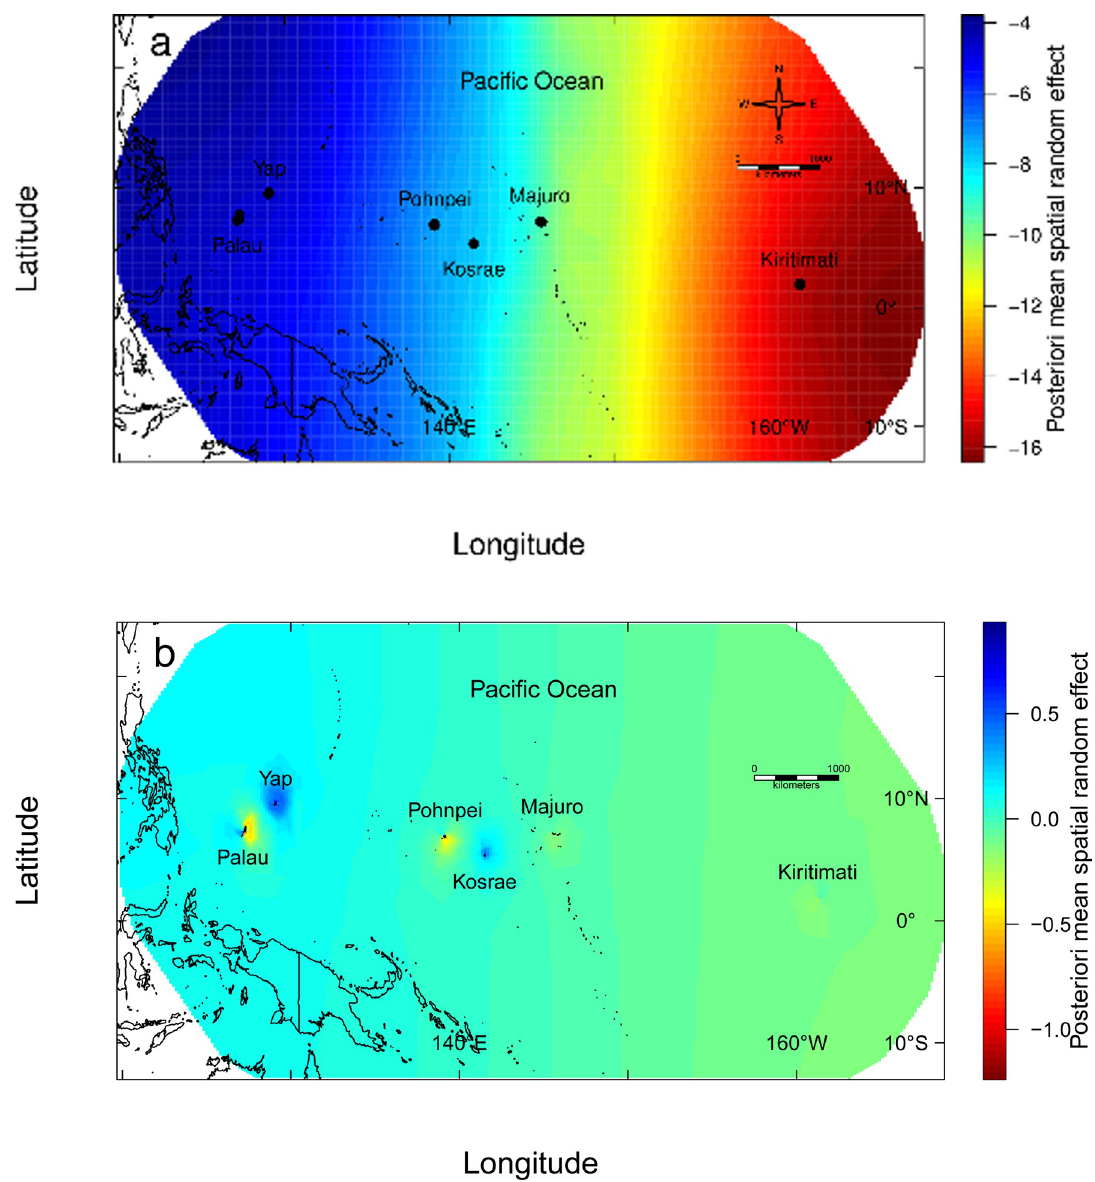
Fig 7. Posterior of mean spatial random effect (a) without and (b) with the frequency of return period thermal-stress covariate incorporated in the Integrated Nested Laplace Approximation model averaged from 6 January 2000 to 26 December 2019 at each of the six Pacific Ocean study locations [i.e., at Palau and Yap (2017), Pohnpei and Kosrae (2018), and Majuro and Kiritimati (2019)]. Outline of land plotted from the R package ‘rworldmap’